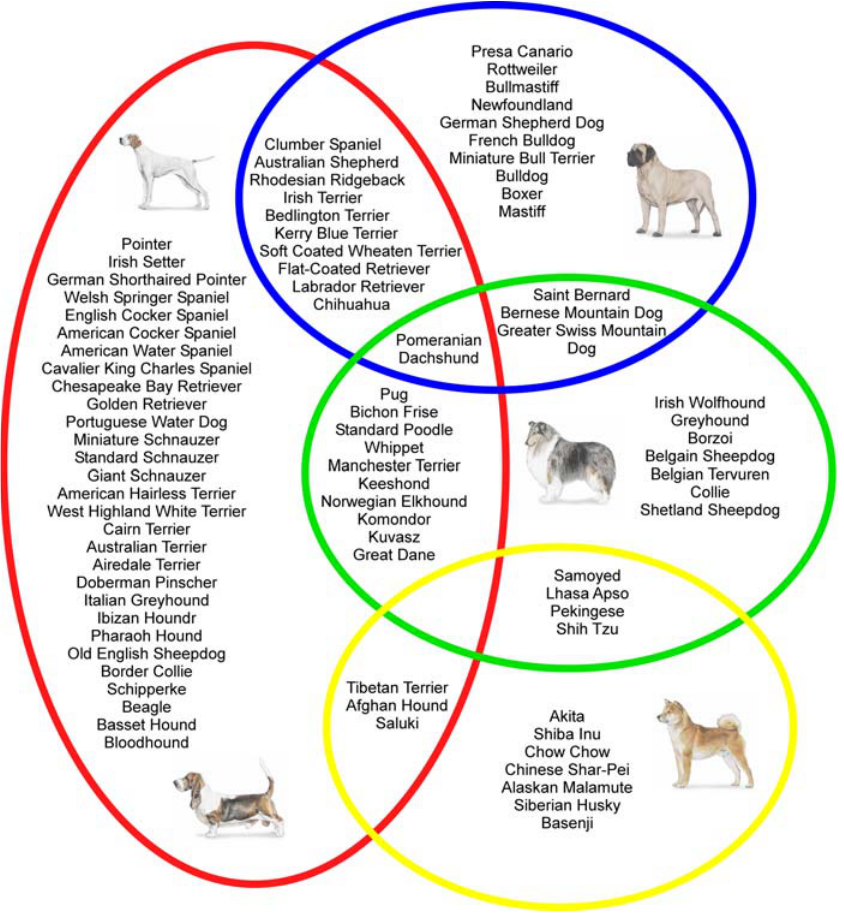
Figure 3. The Population Structure of 85 Dog Breeds The dataset includes five unrelated dogs from each of the 85 breeds that have been genotyped using 96 (CA)n repeat-based microsatellites that spanned the dog genome at an average density of 30 megabases. Clusters were obtained using the computer program Structure [69], which implements a Bayesian model–based clustering algorithm that attempts to identify genetically distinct subpopulations based on patterns of allele frequencies. The work is described in detail in [63]. Four distinct clusters described by Parker et al. are depicted as colored circles: cluster one is yellow, cluster two is blue, cluster three is green, and cluster four is red. Breeds associated with each cluster are listed within the appropriate circle, and examples of breeds are shown in the pictures. Some breeds show patterning similar to more than one cluster, and are listed in the overlapping space. Analysis is ongoing to expand the number of breeds in the dataset and to refine the